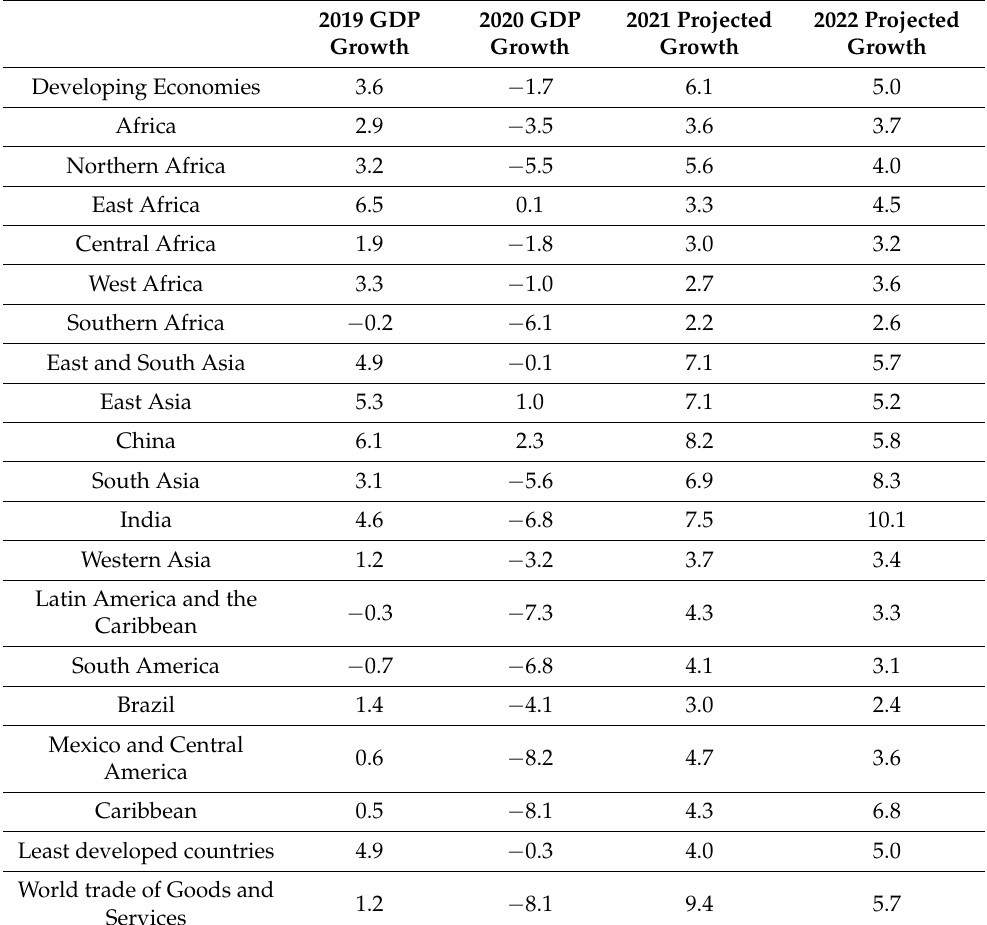
Table 4. Growth of gross domestic product of Developing